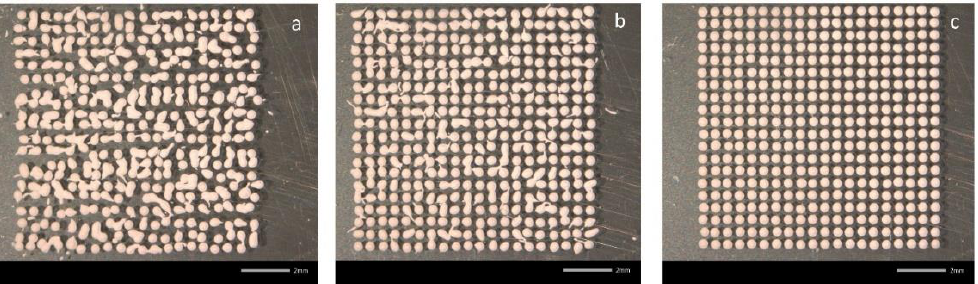
Figure 2. The effects of the nozzle to substrate distance: ( a ) 3 mm, ( b ) 2 mm and ( c ) 1 mm.